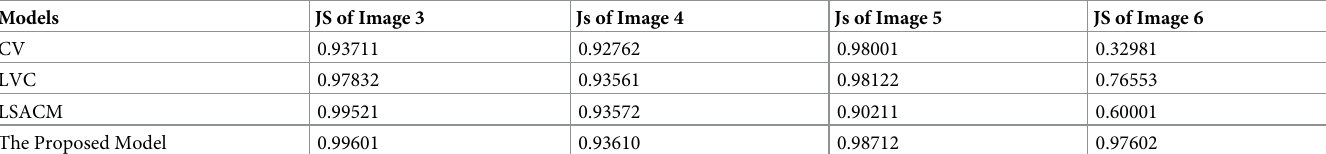
Table 3. Comparisons of Jaccard similarity coefficient of Fig 6.